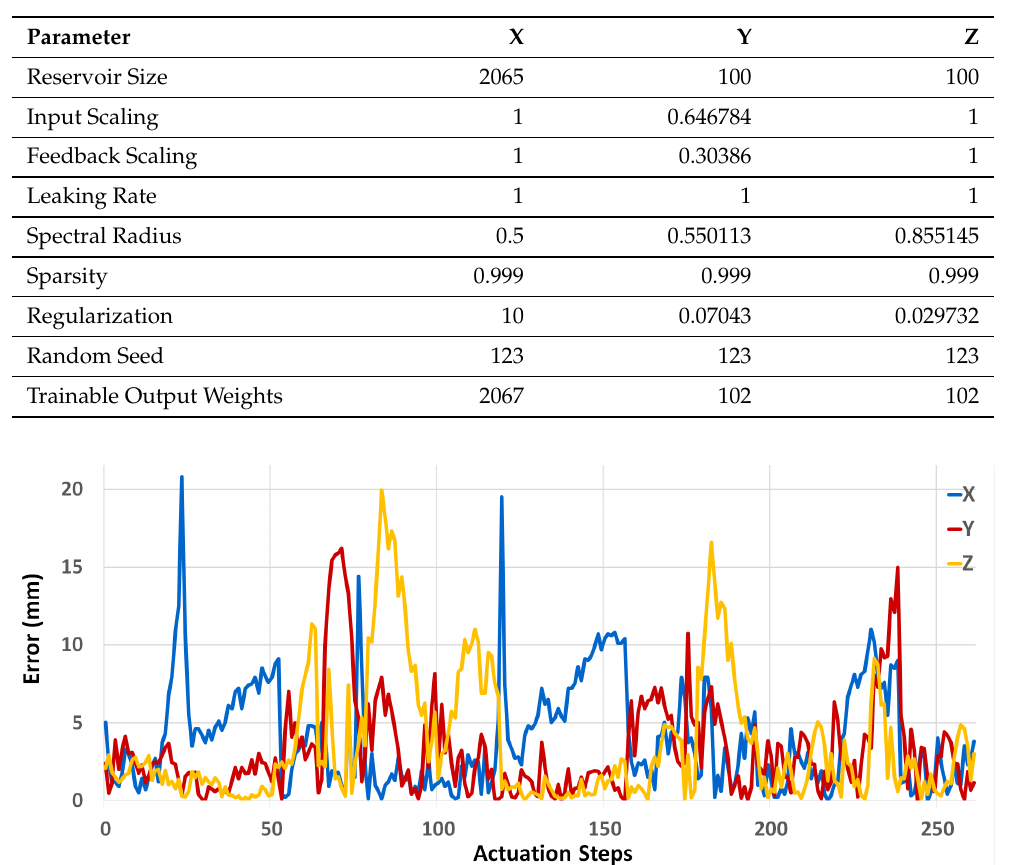
Table 1. Optimized Parameters of ESN for the 3 individual axes.